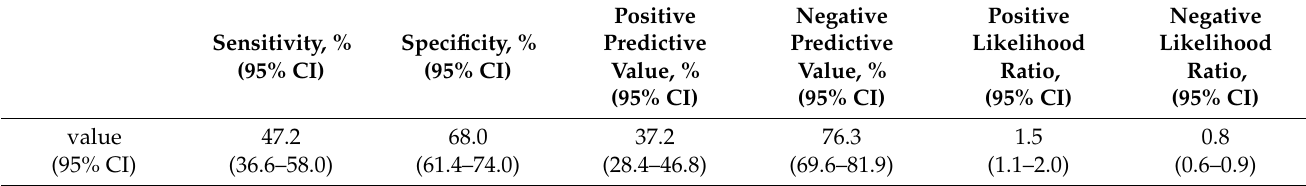
Table 2. Performance of SIRS criteria in predicting serious